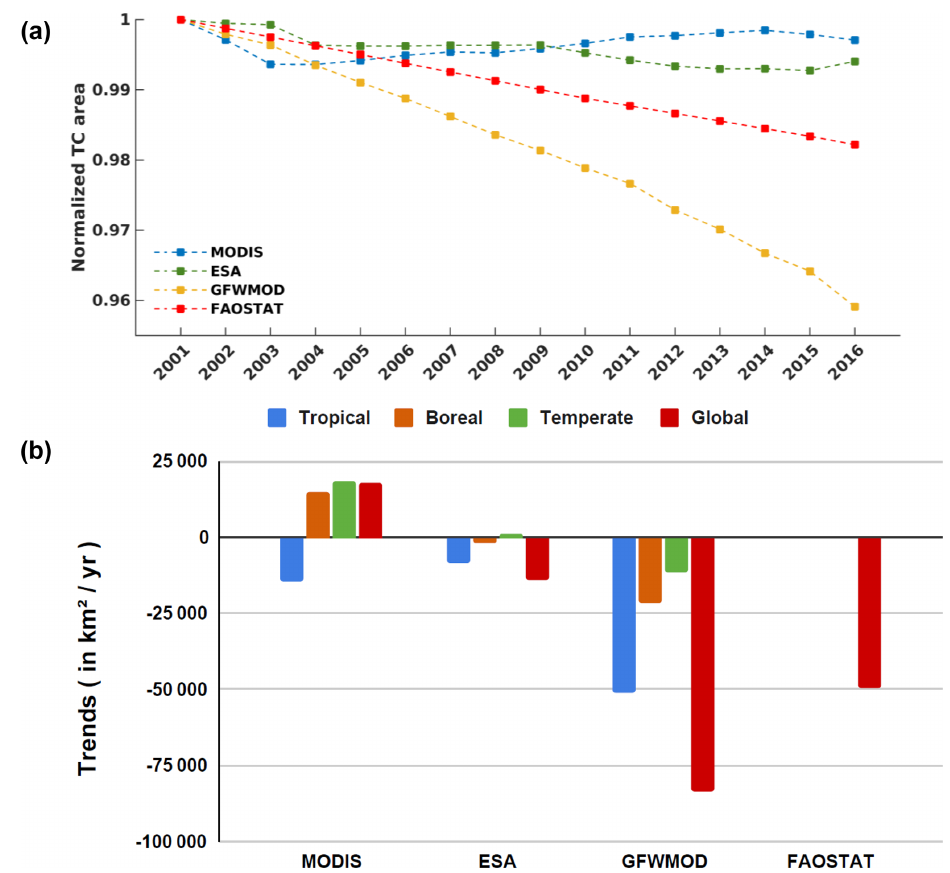
Figure 2. TC trends over 2001–2016. (a) Time series of the global net changes in TC areas (normalized to 2001 values) from FAOSTAT, MODIS, ESA, and GFWMOD datasets and (b) total net TC trends at global scale and per climate zone (as defined in Sect. 2 in the Supplement and depicted in Fig. S2b). For the FAOSTAT dataset, TC trends per climate zone are not